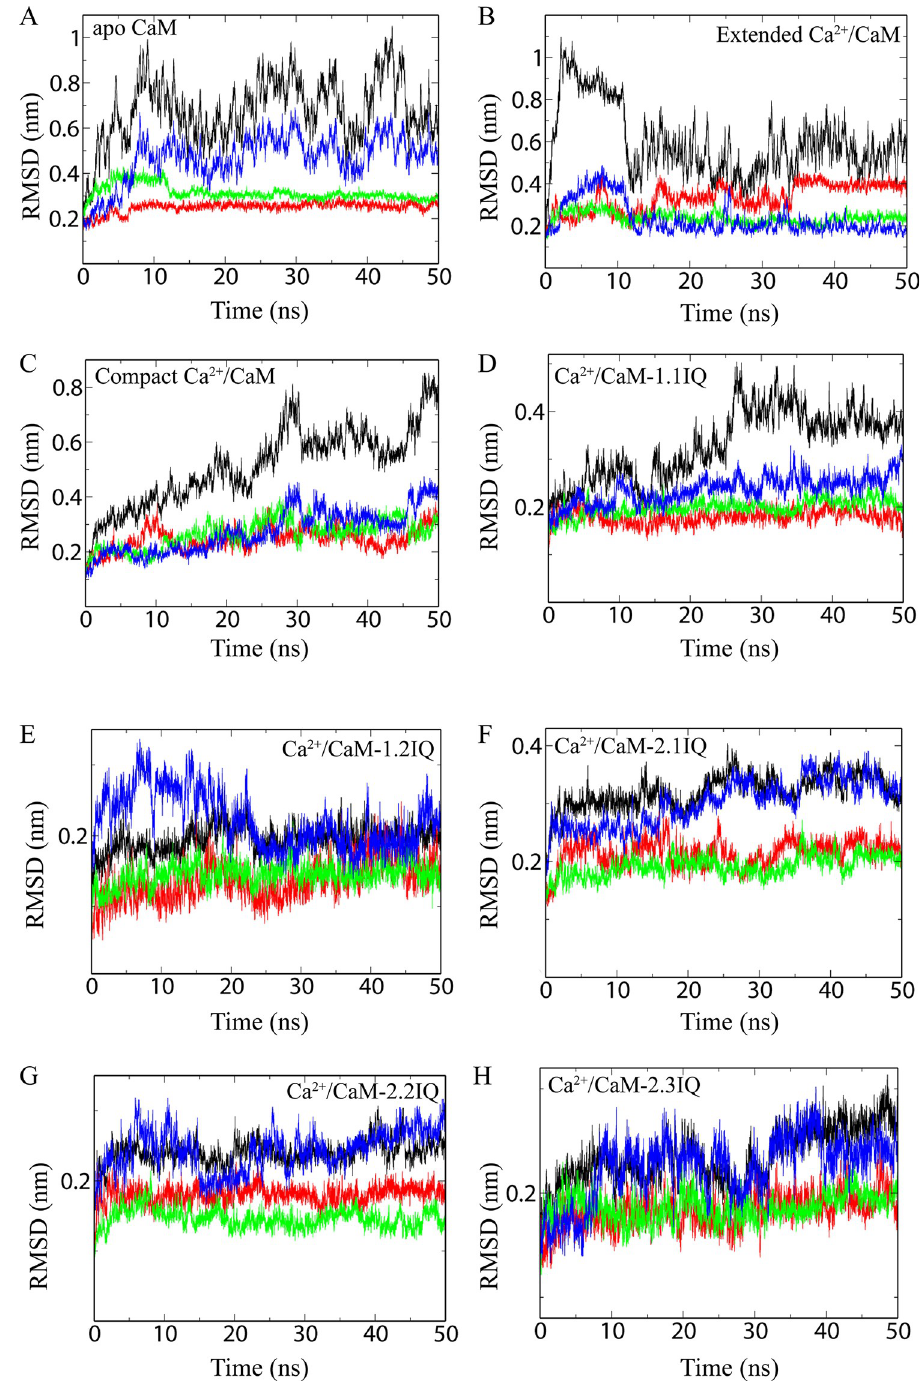
Fig 2. Root-mean-square deviation (RMSD) of CaM complexes. (A) apo CaM (1CFD), (B) extended Ca 2+ /CaM (1CLL), (C) compact Ca 2+ /CaM (1PRW), (D) Ca 2+ /CaM-Cav1.1IQ (2VAY), (E) Ca 2+ /CaM-Cav1.2IQ (2BE6), (F) Ca 2 + /CaM-Cav2.1IQ (3DVM), (G) Ca 2+ /CaM-Cav2.2IQ (3DVJ), and (H) Ca 2+ /CaM-Cav2.3IQ (3BXL). The RMSD curve of the whole complex (black), N-lobe (red), C-lobe (green), and central helix (blue) are shown.